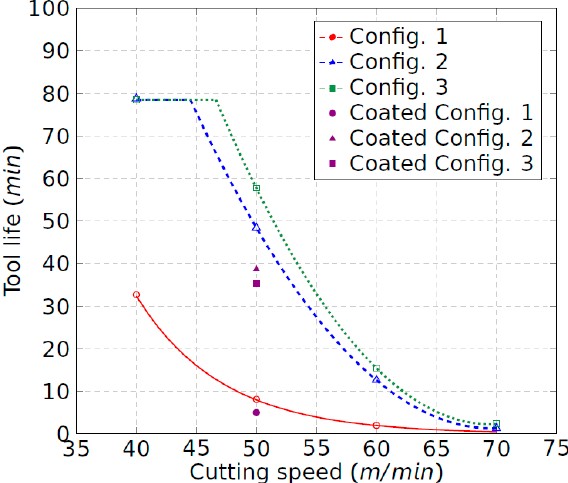
Figure 5. Tool life curves for each configuration.